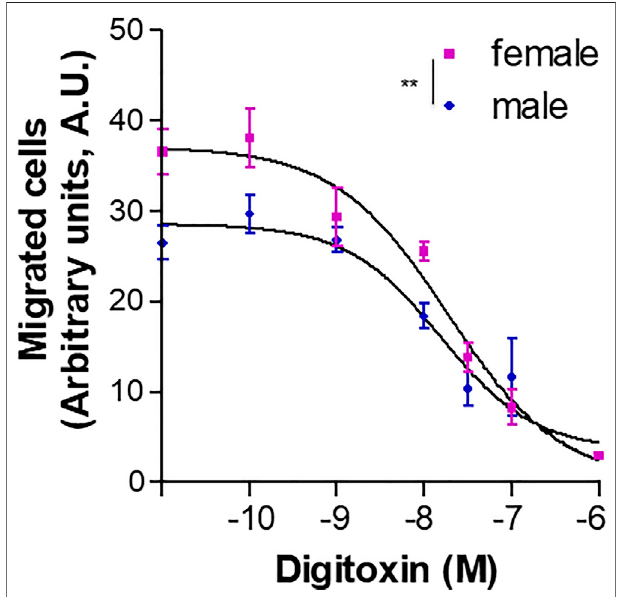
FIGURE 10 | Effect of digitoxin on HUVEC chemotaxis. Migration of HUVECs from male and female donors towards 15% FBS plus 100 μ g/ml ECGS was measured in a microchemotaxis chamber in the presence of increasing concentrations (0.1 nM – 1 µM) of digitoxin. Cell migration is shown as optical density values (A.U., arbitrary units). Each independent experiment ( n (cid:1) 5) was performed in sextuplicate using cells from one male andonefemaledonor.Dataareexpressedasmean ± SEM.Two-wayANOVA for comparison between curves, ** p < 0.01.